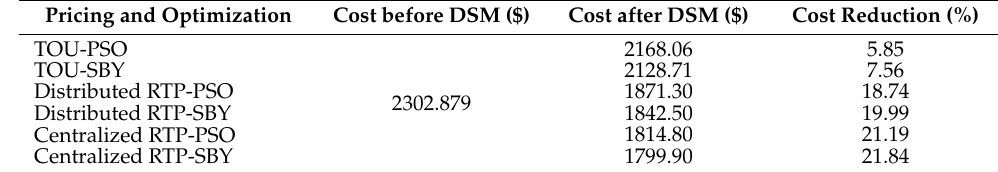
Table 8. Comparison of DSM with the TOU and RTP pricing for the residential area.